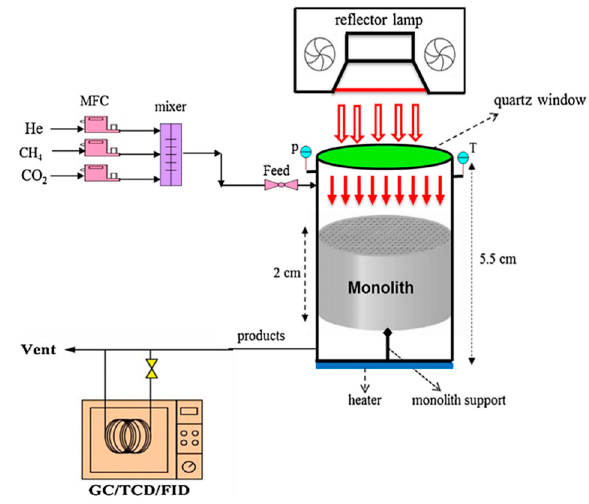
Figure 10. Another reactor design for photocatalytic methane reforming: (1) thermocouple, (2) gas outlet, (3) aluminum foil, (4) sieve plate, (5) heater, (6) graphite plate, (7) mercury lamp, (8) cata- lyst inlet, (9) quartz reactor, (10) catalyst bed, (11) gas inlet, and (12) fan [32]. Reprinted from [33], with permission from Elsevier.